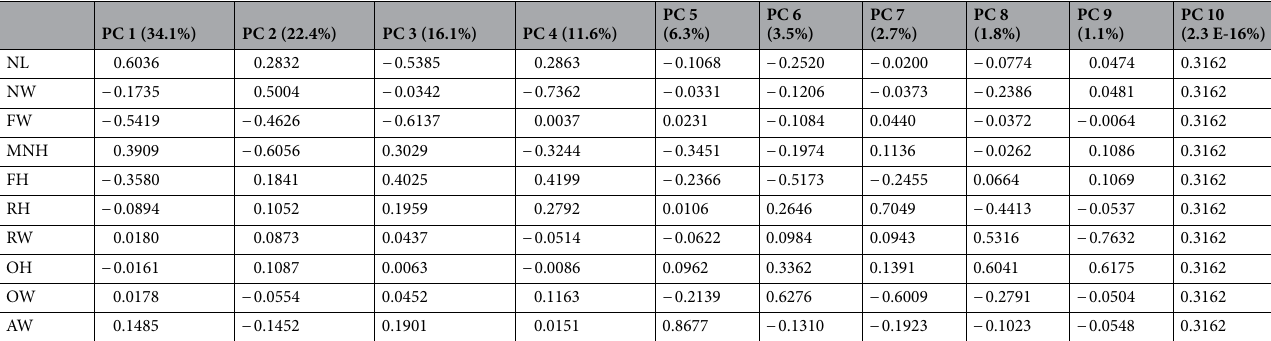
Table 3. Principal component loadings. NL Neurocranial length, NW Neurocranial width, FW Facial width, MNH Midneural height, FH Facial height, RH Respiratory height, RW Respiratory width, OH Optic height, OW Optic width, AW Alveolar width.